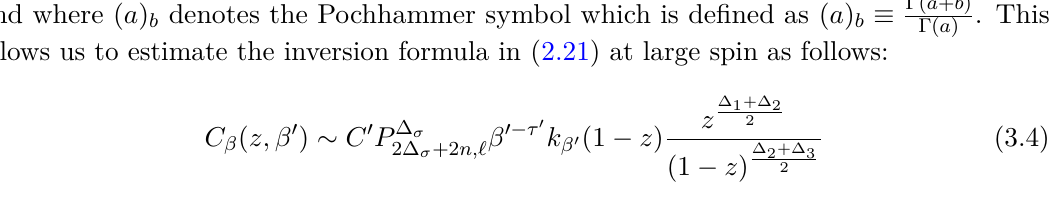
≡ Γ( a + b ) . This b Γ( a )